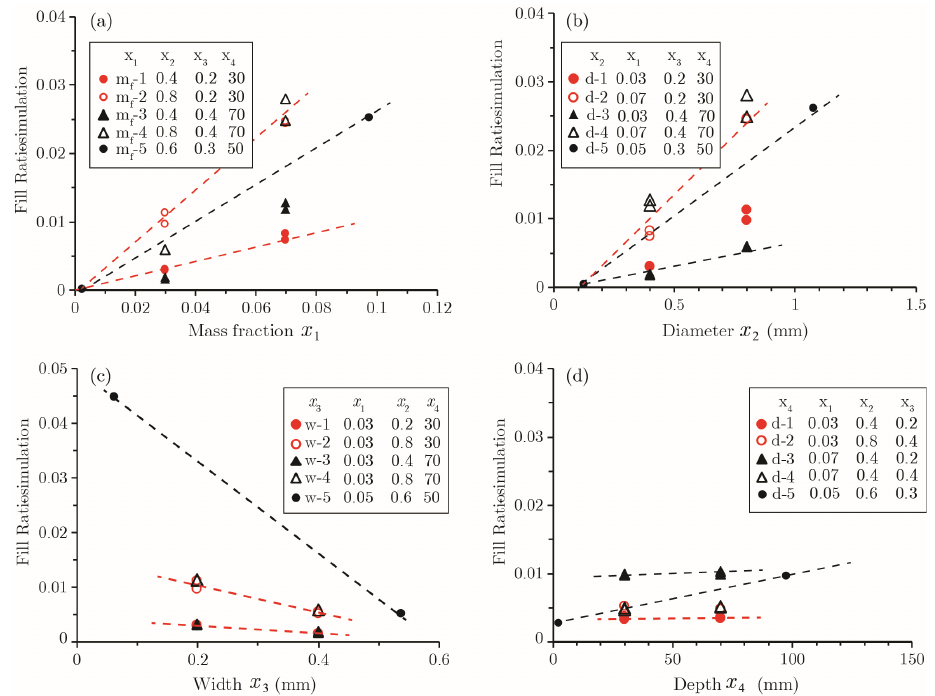
Figure 13. Variation of 𝑅 (cid:3033)(cid:2879)(cid:2877)(cid:2873) with different variables under various combinations. Analyzing the coefficient values of the regression model, the following relationships